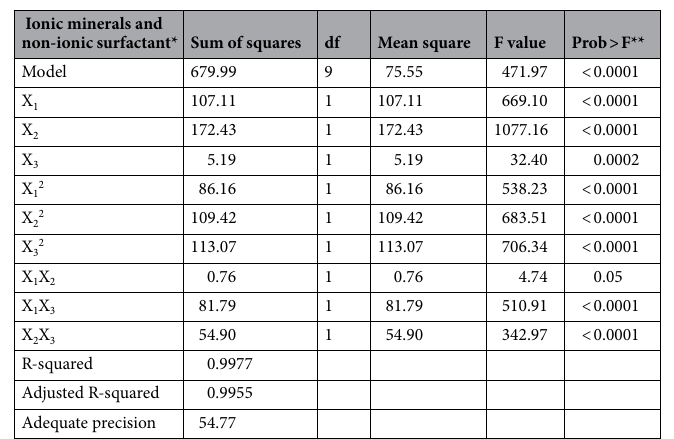
Table 7. ANOVA analyses for CCD models of ionic minerals and non-ionic surfactant on the antimicrobial activity of postbiotic RS5 produced by L. plantarum RS5. *X 1 : sodium acetate; X 2 : Tween 80; X 3 : manganese sulphate tetrahydrate. **Value of “Prob > F” less than 0.05 indicates that the model terms are